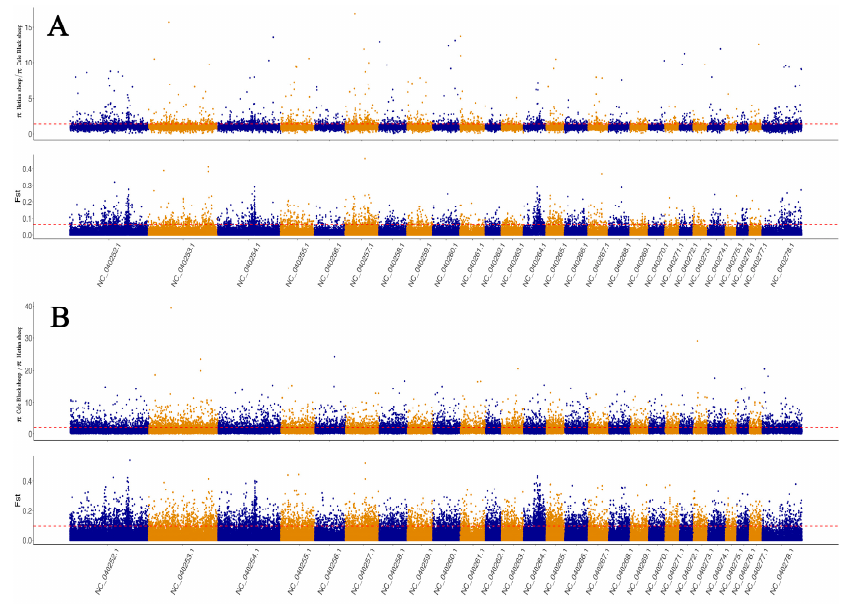
Figure 3. ( A ): The area above the dotted line includes Hetian sheep/Cele Black sheep are subject to selection. ( B ): The area above the dotted line includes Cele Black sheep/Hetian sheep subject to